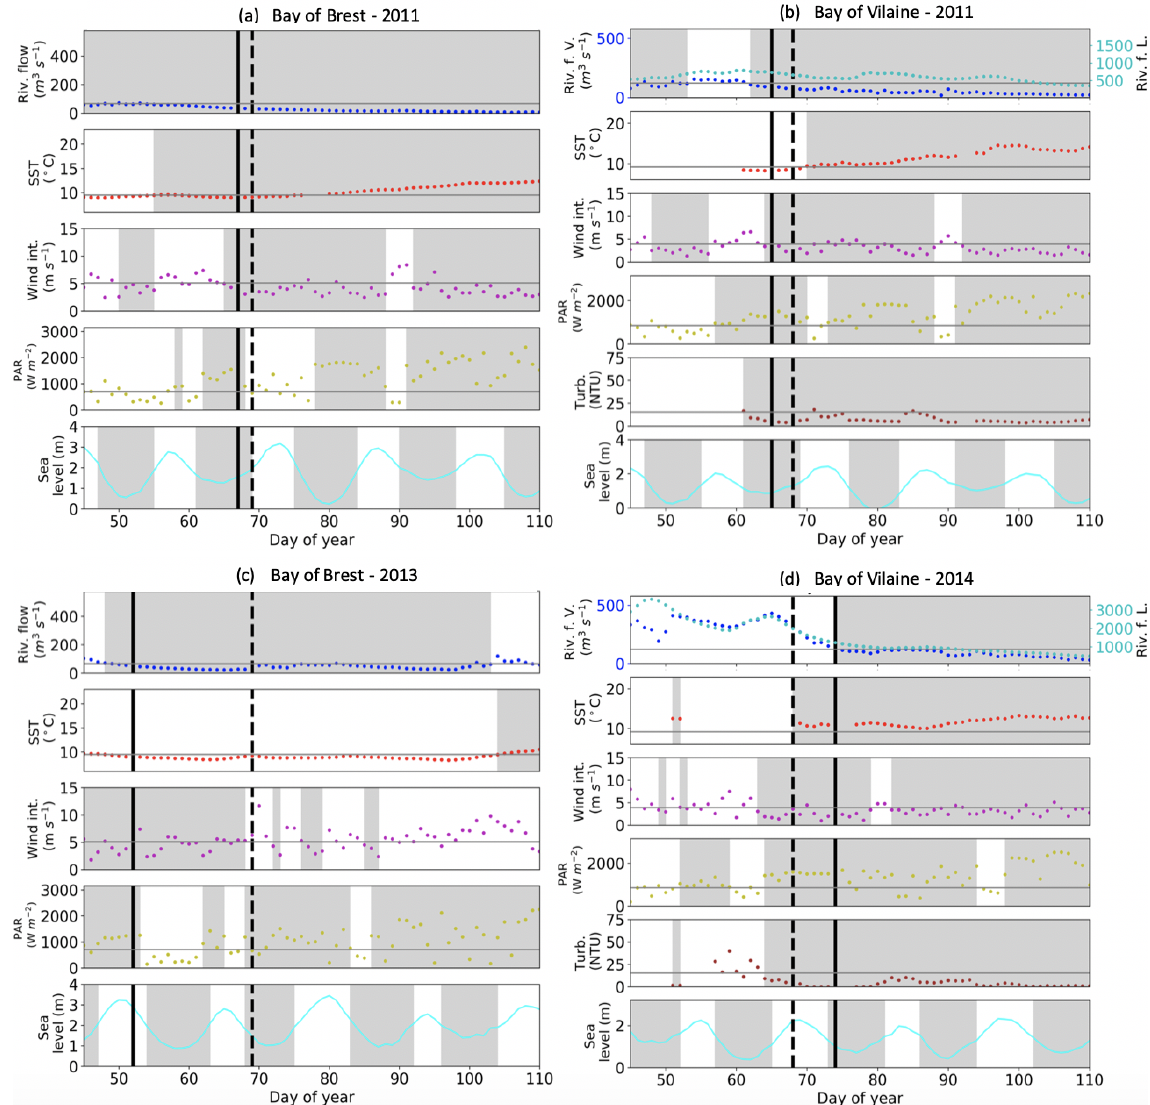
Figure 7. IPGP dates and environmental drivers: flow of the Aulne, Vilaine, and Loire rivers, sea surface temperature, wind intensity, PAR, turbidity, and sea level at high tide. Illustrations for a mean IPGP date in (a) the Bay of Brest and (b) the Bay of Vilaine in 2011; for an early IPGP date in (c) the Bay of Brest in 2013; for a late IPGP date in (d) the Bay of Vilaine in 2014. The mean IPGP date of each bay is represented by a dashed black line, and the IPGP date of the year is represented by a solid black line. Thresholds of each environmental driver are represented by grey horizontal lines corresponding to the mean conditions calculated 30d around the IPGP date. Grey areas are time periods favourable to the